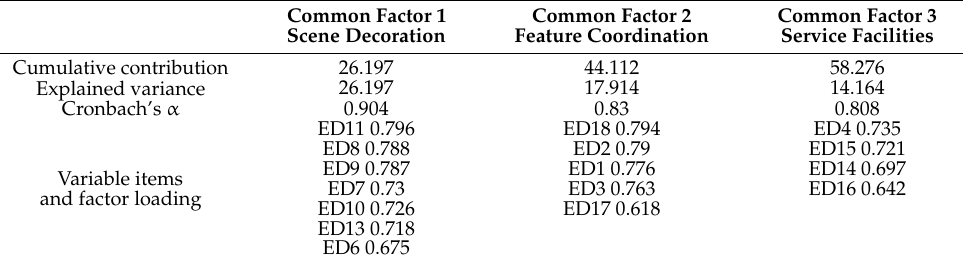
Table 7. EFA result for environmental design.